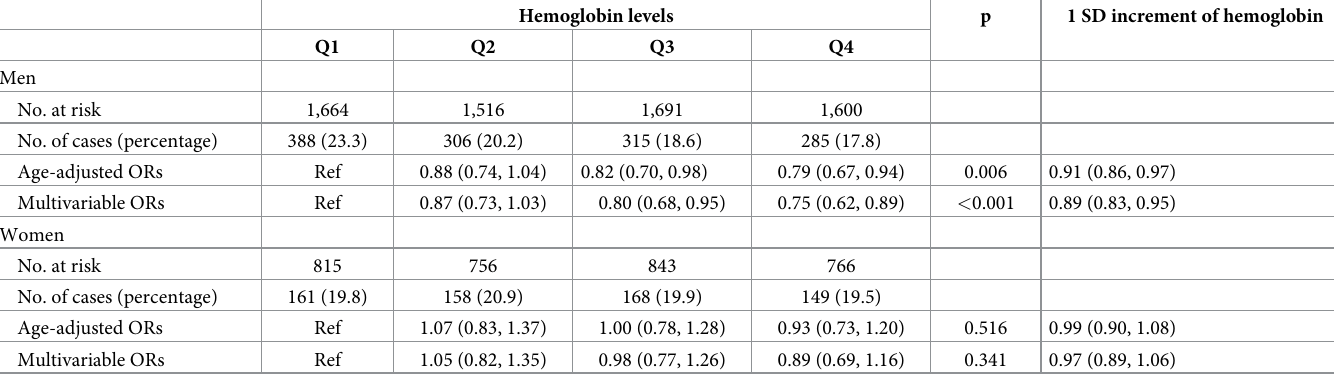
Table 2. Odds ratios (OR) and 95% confidence intervals (CI) for height loss in relation to hemoglobin levels.